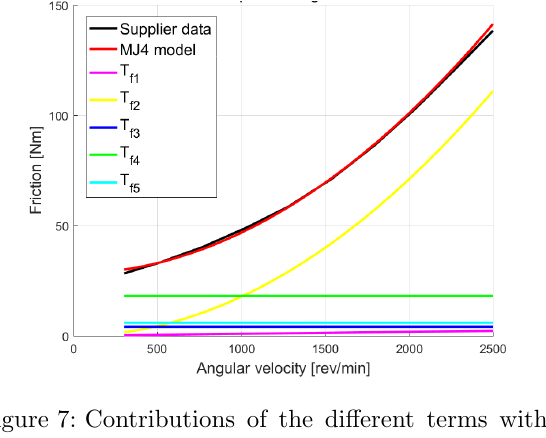
Figure 7: Contributions of the different terms within the motor friction formula MJ4. Motor dis- placement is set to 250 cm 3 /rev and pressure drop across motor is held constant at 200bar. C n in T f 2 equal